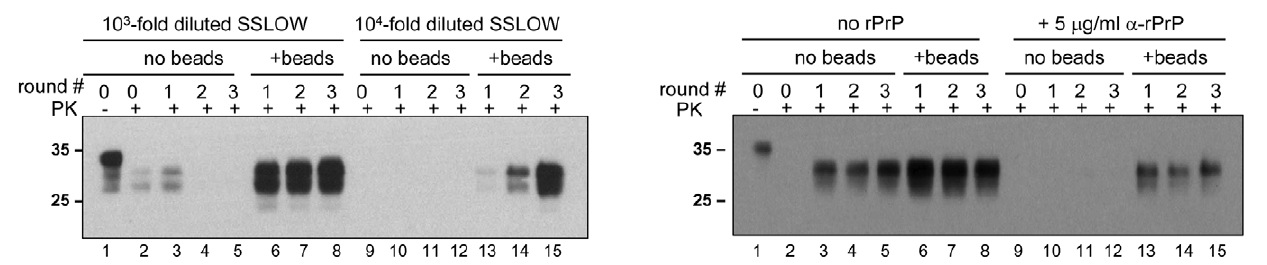
Figure 6. Beads counteract the negative effect of rPrP on PrP Sc amplification. 263K scrapie brain material was diluted 10 3 -fold into 10% NBH and subjected to a serial PMCA in the absence or presence of a -rPrP (5 m g/ml) and absence or presence of 3 small beads, as indicated. Each PMCA round consisted of 48 cycles; the material amplified in each round was diluted 10-fold into 10% NBH for the next PMCA round. Undigested 10% NBH (lane 1) loaded at 1/10 th the amount of the digested samples is provided as a